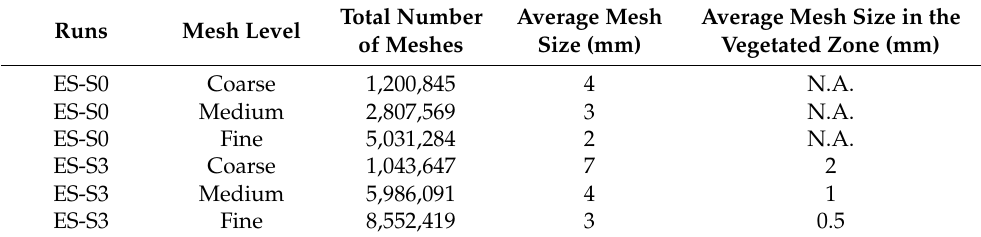
Table 2. Parameters of numerical runs for the mesh independence